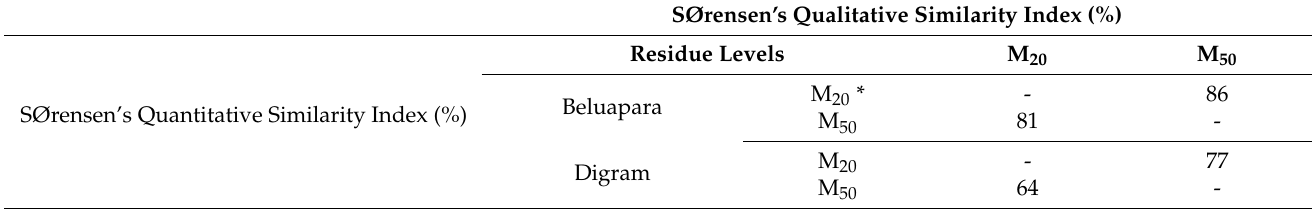
Table 4. Effect of residue levels on the SØrensen’s qualitative and quantitative similarity index (%) of the weed seedbank after 3 years in Beluapara and 5 years in